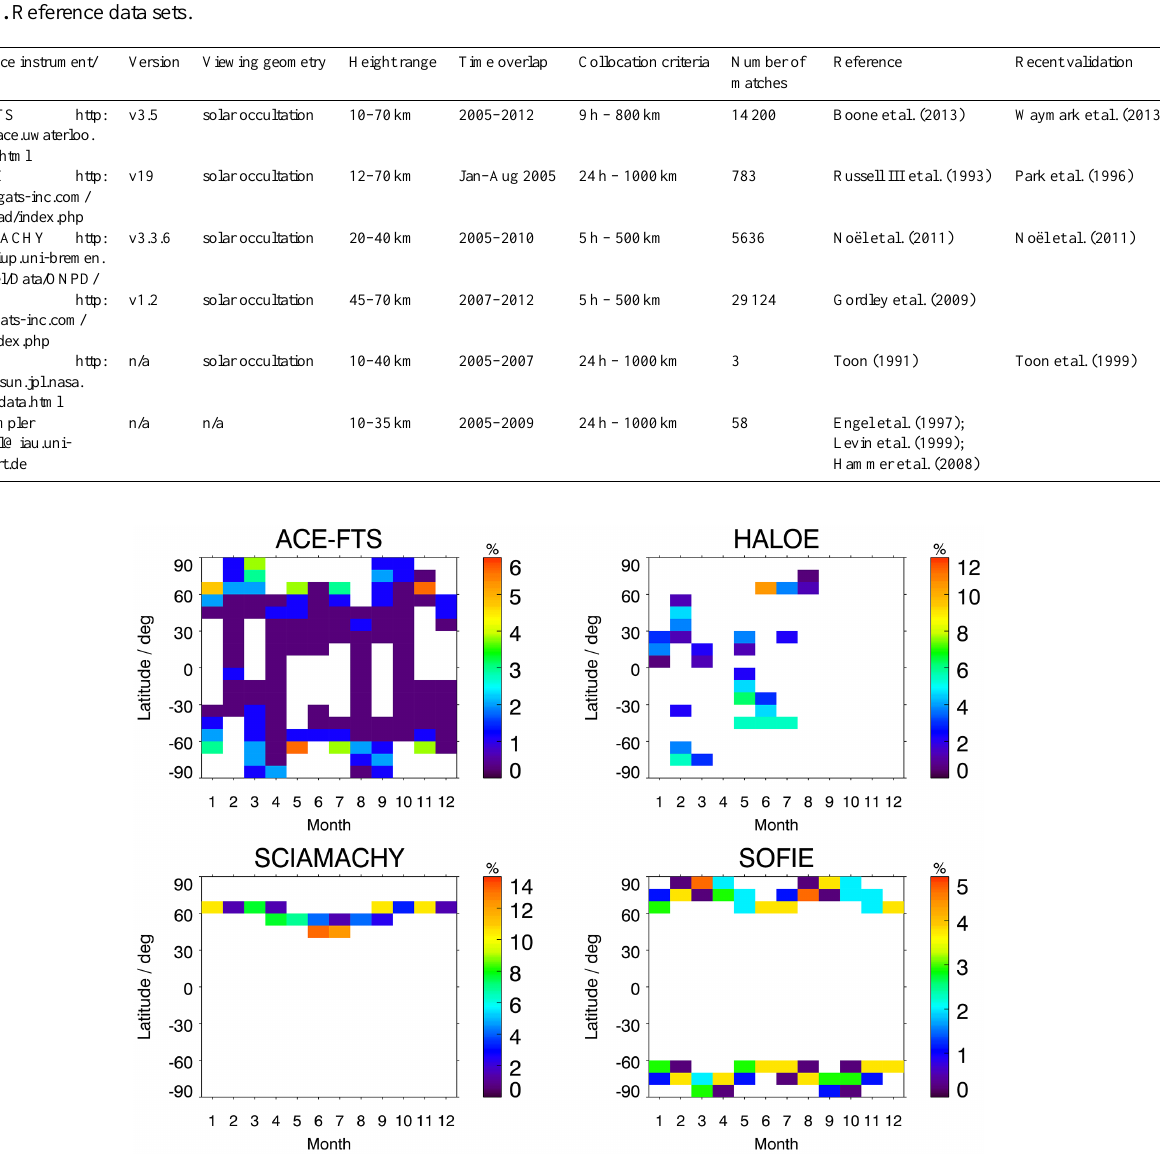
Table 2. Reference data sets.